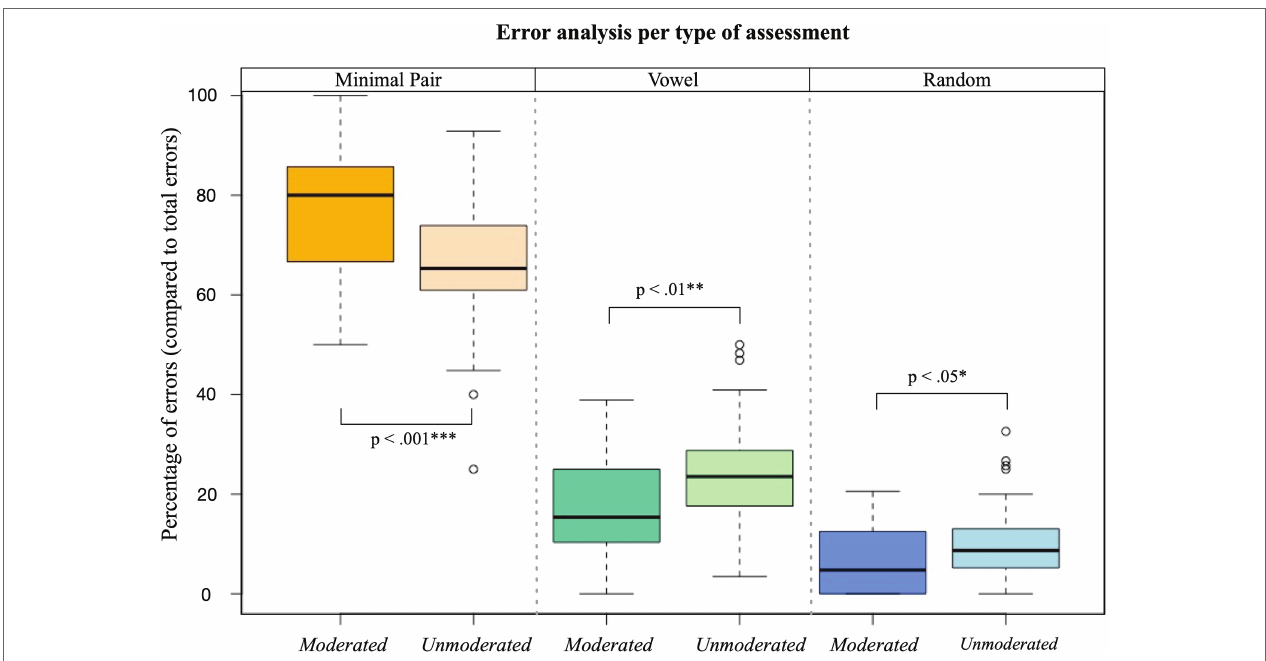
FIGURE 4 | Comparison of a moderated (N = 37) and unmoderated (N = 47) version of the AV task in 6-to 7-year-olds. The expected error pattern minimal pair > vowel > random errors is shown in both tasks, but more distinct for the moderated task. Random errors, and there for lack of attention is significantly higher in the unmoderated task. Thick horizontal lines represent medians, boxes represent interquartile ranges, and whiskers represent range, excluding outliers. Outliers are defined as values falling more than 1.5 x below or above the 25th and 75th percentiles, respectively, and are shown as circles. Significance: * p < 0.05, ** p < 0.01, *** p <